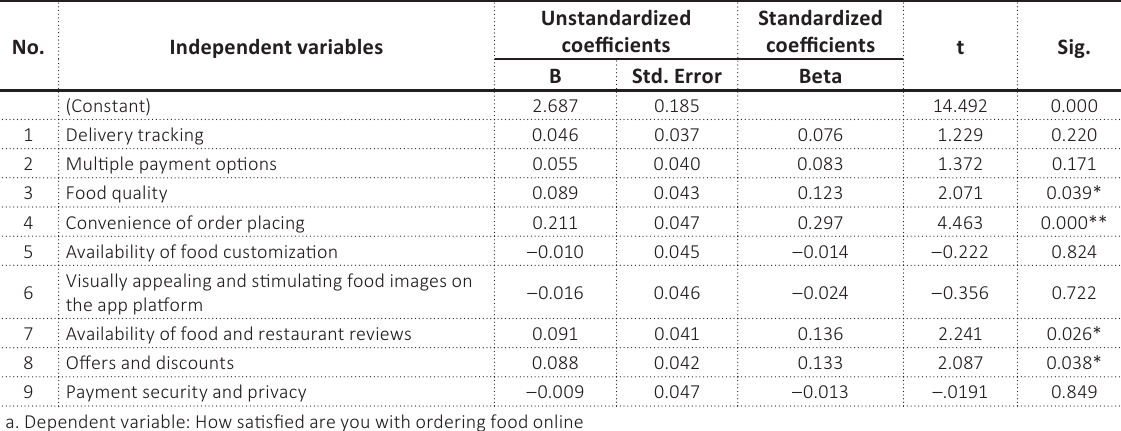
Table 11. Regression analysis of hypothesis